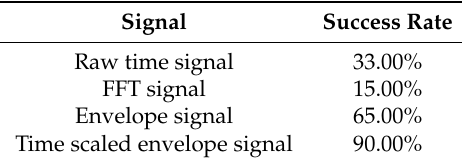
Table 1. Success rate results for the different datasets that trained the